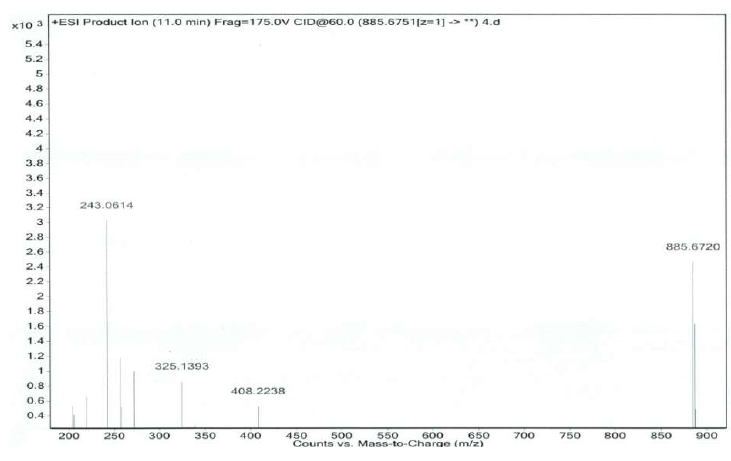
/ MS spectrum of impurity X. Figure 7. MS/MS spectrum of impurity X. Figure 7. MS Figure 7. MS/MS spectrum of impurity X.